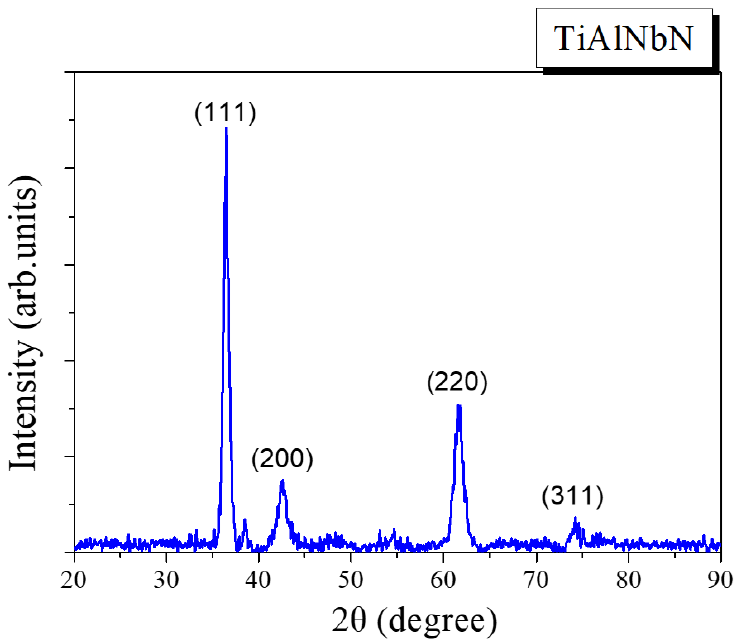
Figure 2. Glancing angle X-ray diffraction pattern of the deposited TiAlNbN coating.